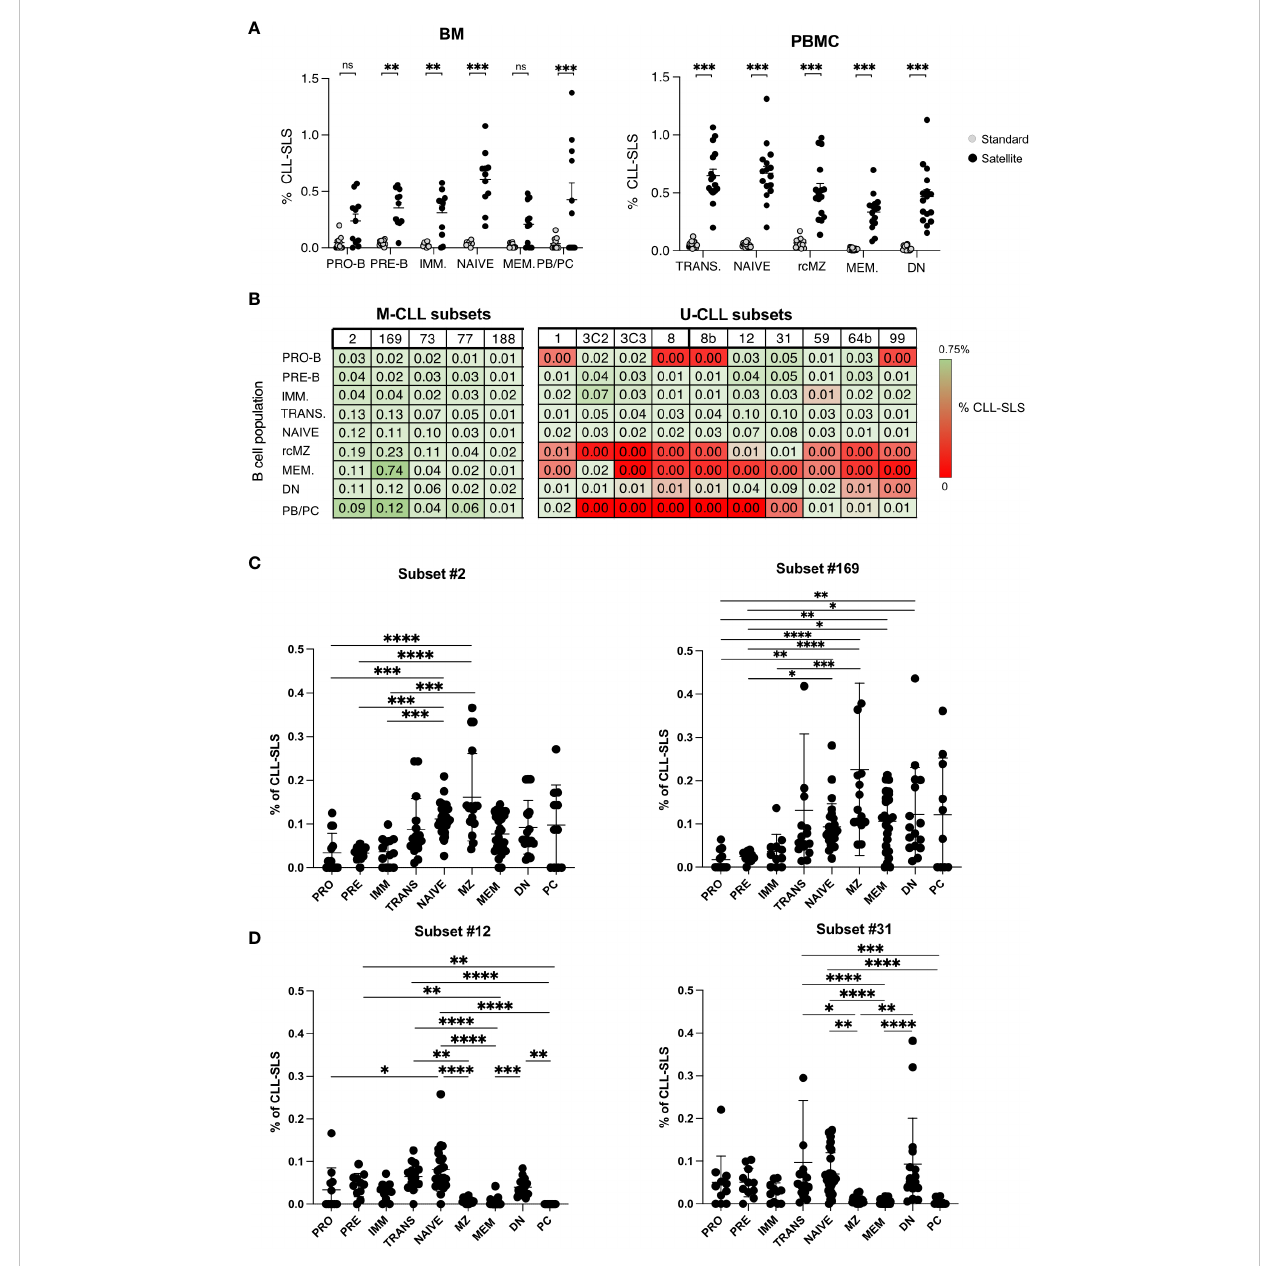
FIGURE 5 (A) Left Panel: Summary plot comparing frequencies of standard and satellites CLL-SLS in different B cell subsets in BM. Right Panel: Summary plot comparing frequencies of standard and satellites CLL-SLS in different B cell subsets in PBMC. (B) Upper panel: Table summarizes average frequency of the most frequent satellite CLL-SLS divided by subsets through different stages of B cell development. Lower panel: Table summarizes average frequency of the less frequent satellite CLL-SLS divided by subsets through different stages of B cell development. (C) Summary plot of satellite CLL- SLS frequencies attributed to subset #2 and #169 through different stage of B cell development (Mean with SEM). Statistical analysis and multiple comparisons were performed with Kruskal-Wallis test. (D) Summary plot of satellite CLL-SLS frequencies attributed to subset #12 and #31 through different stage of B cell development (Mean with SEM). Statistical analysis and multiple comparisons were performed with Kruskal-Wallis test. * p ≤ 0.05, **p ≤ 0.01,***p ≤ 0.001, ****p ≤ 0.0001. ns, not signi fi